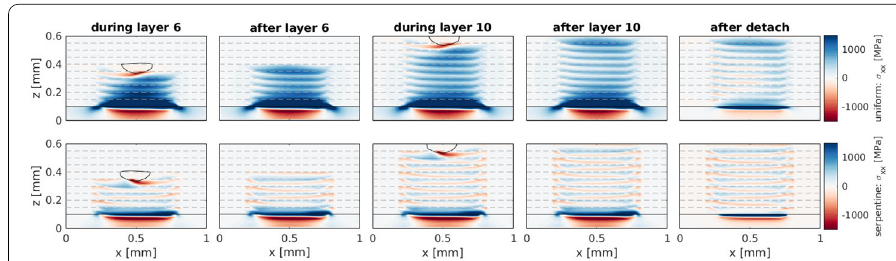
Fig. 17 Stress distribution of σ xx in symmetry plane at selected time steps for unidirectional (first row) and serpentine (second row) scanning pattern. Blue color represents tension, red color represents compression. Liquidus isotherm (solid black line) approximates melt pool shape. For improved visibility of the relevant stresses the color bar is